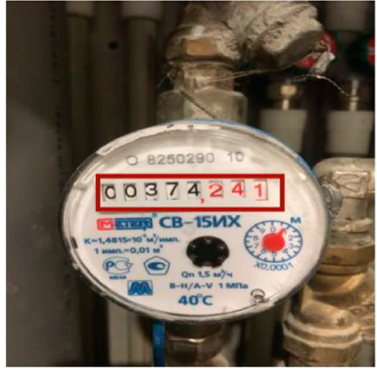
Figure 7. Data Labeling.